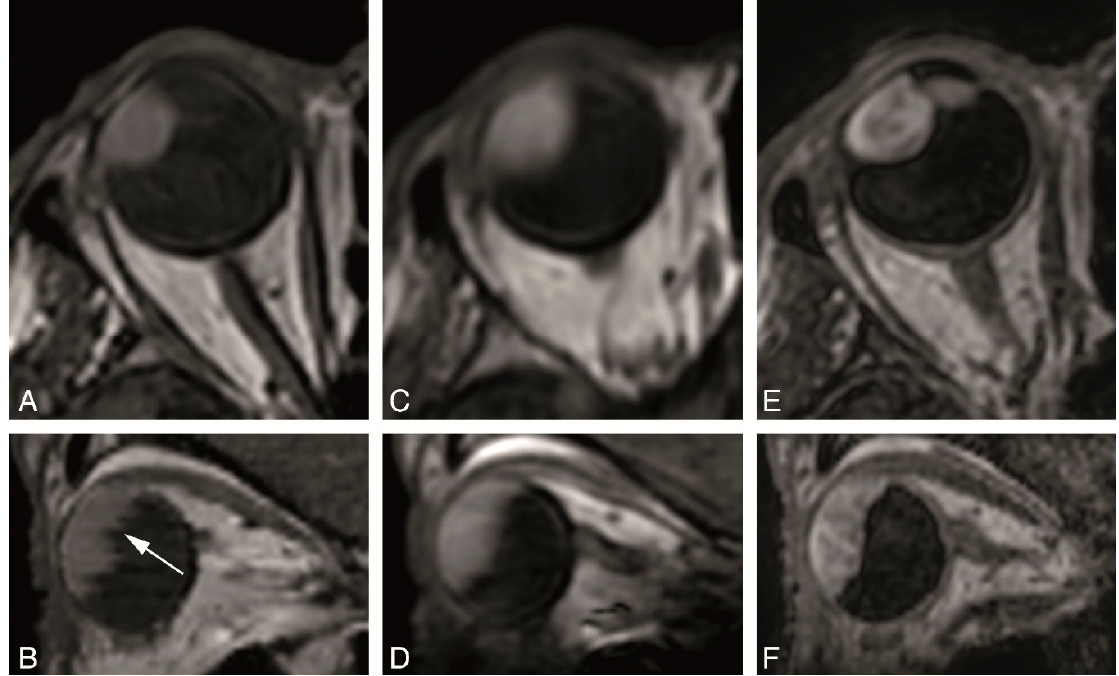
Figure 5. ( A – F ) MS 1 mm versus 3D sequences in a patient with a uveal melanoma of the right eye. ( A , B ) MS 1 mm axial T1 ( A ) and sagittal reconstruction ( B ). ( C , D ) 3D TSE 1 mm axial T1 ( C ) and